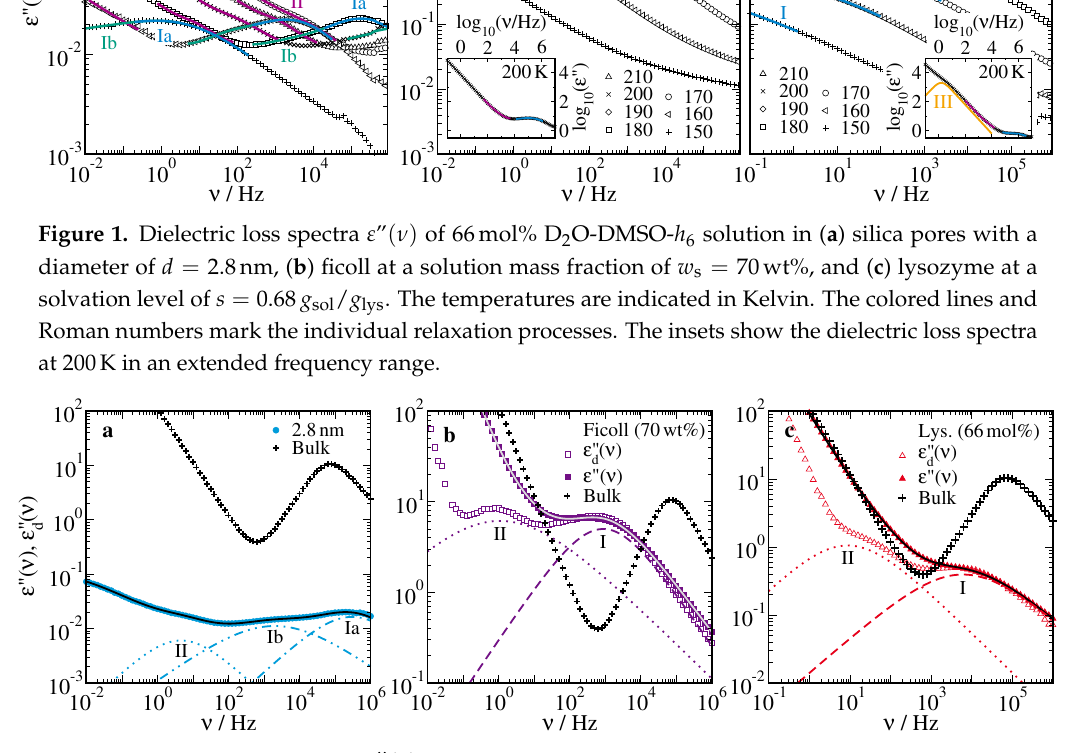
Figure 2. Dielectric loss spectra ε (cid:48)(cid:48) ( ν ) of 66mol% D 2 O-DMSO- h 6 solution in various confinements at 180K: ( a ) in silica pores with a diameter of d = 2.8nm, ( b ) in ficoll at a solution mass fraction of w s = 70wt%, and ( c ) in lysozyme at a solvation level of s = 0.68 g sol / g lys . In each panel, the results for the bulk solution at 180K are included [57]. The solid lines are fits of the data for the confined solutions to Equation (2). The dashed, dash-dotted, and dotted lines indicate the contributions of the individual Cole–Cole (CC) relaxation processes. In panels ( b ) and ( c ), the corresponding derivative of the real part ( ν ) is shown for of the dielectric permittivity, − d ε (cid:48) ( ν ) / d ln ν ∼ ε (cid:48)(cid:48) d